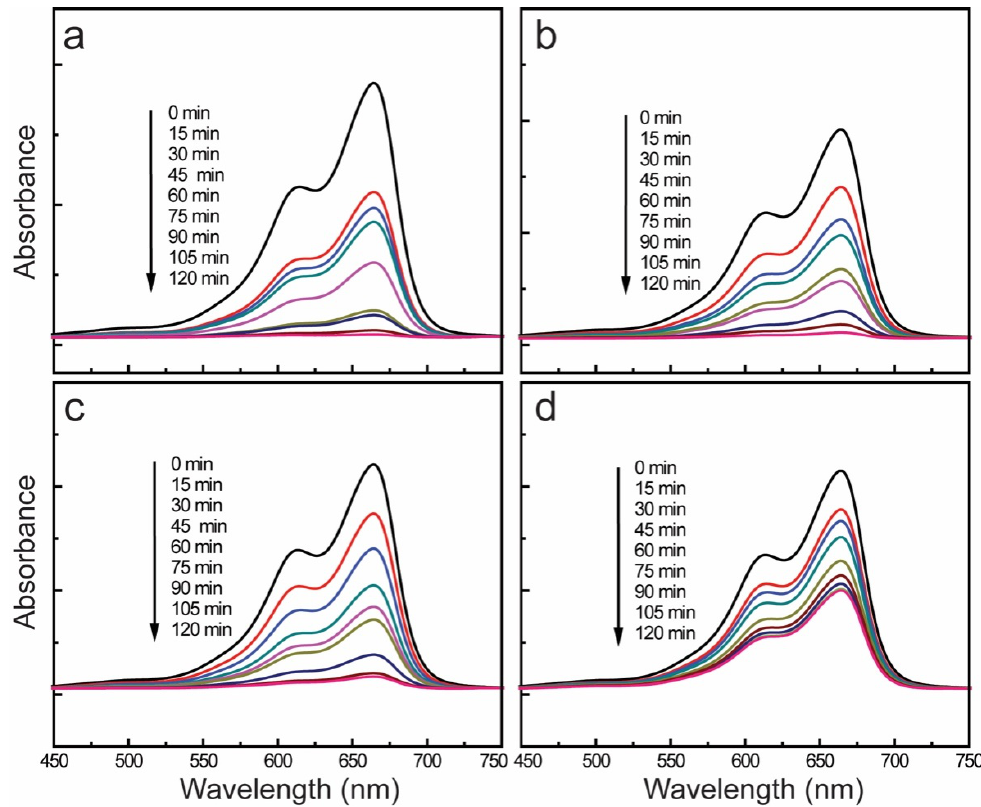
Figure 6. UV-vis absorbance spectra of the methylene blue (MB) solution as a function of time, showing the photodegradation achieved with ( a ) CuO-SWCNT-5, ( b ) CuO-SWCNT-2, ( c ) CuO-SWCNT-0.5, and ( d ) pristine CuO nanocrystals.